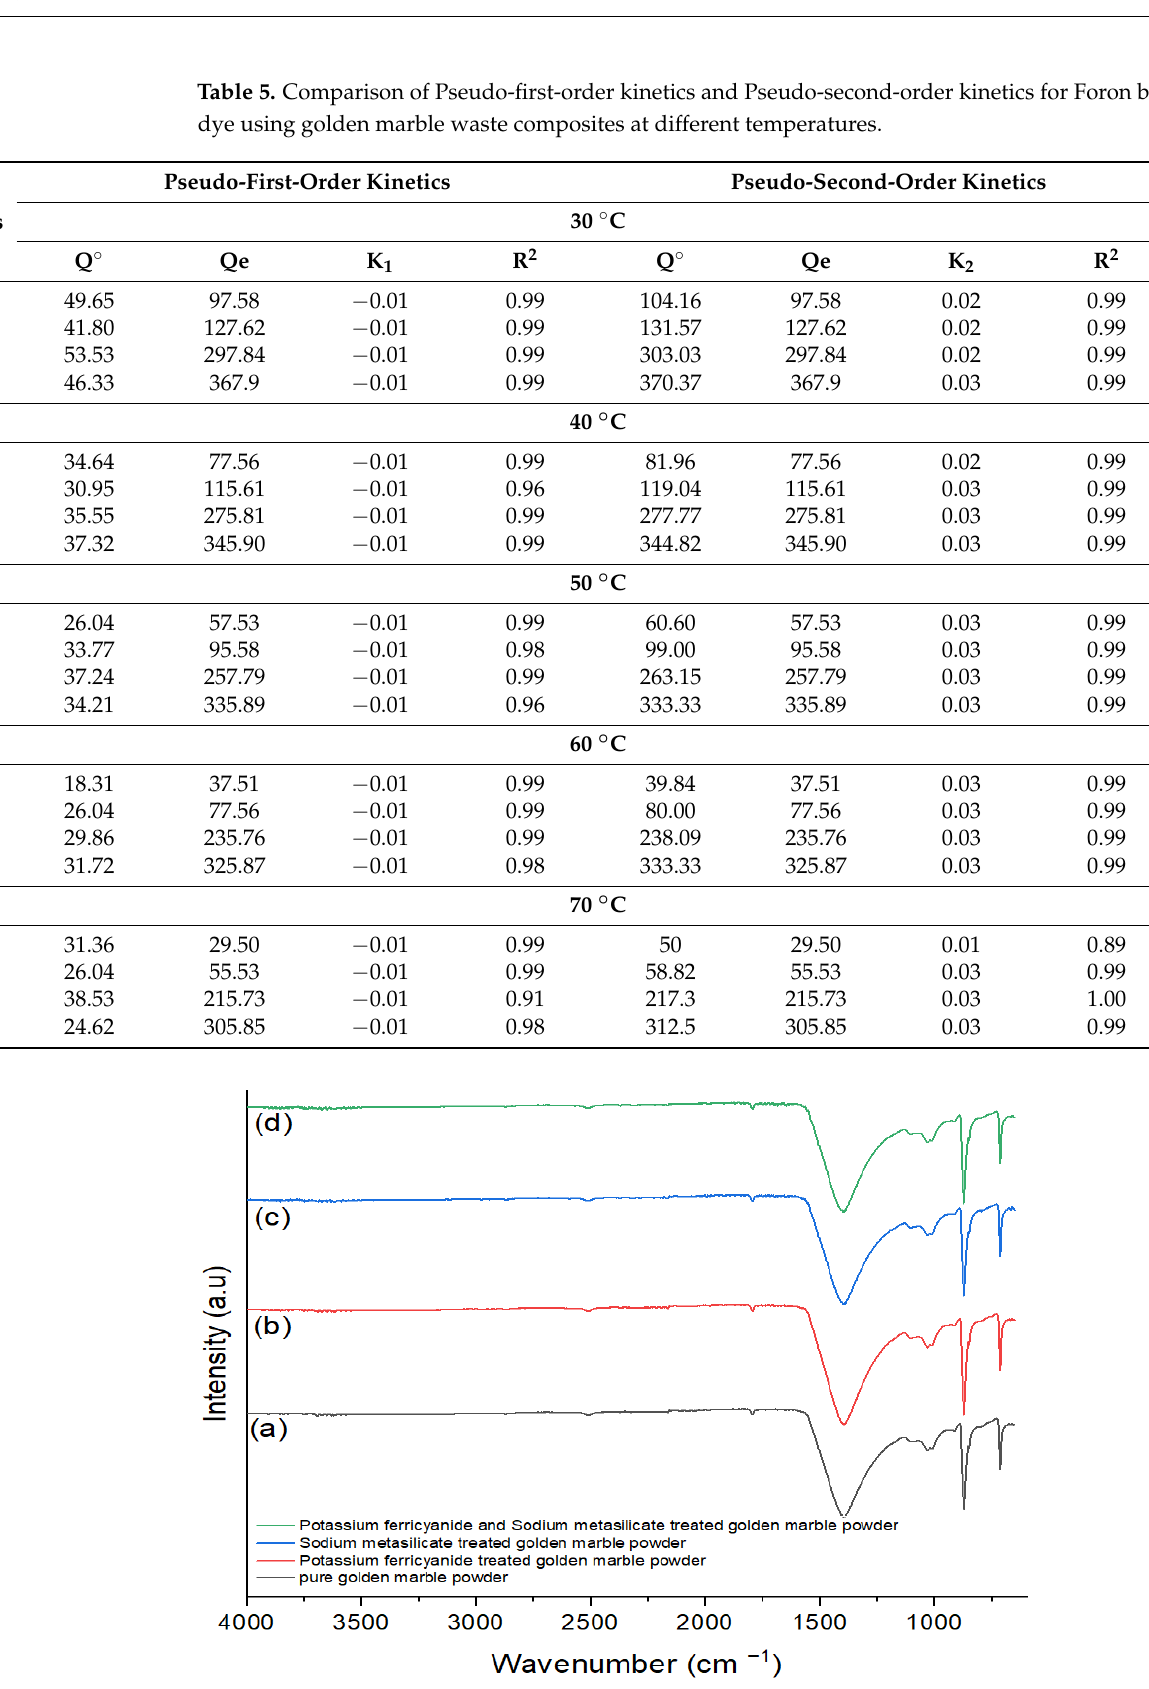
Figure 5. FTIR analysis of ( a ) pure golden marble powder, ( b ) potassium ferricyanide treated golden marble powder, ( c ) sodium metasilicate treated golden marble powder, and ( d ) potassium ferricya- nide and sodium metasilicate treated golden marble